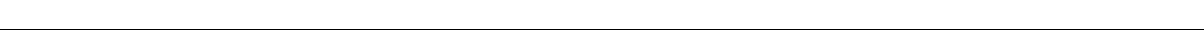
Fig. 1 Optimal delivery of mod-mRNAs and m-miRNAs enhances the reprogramming of human primary fi broblasts. a Transfection ef fi ciency (top) and mean fl uorescence intensity (bottom) of human primary neonatal fi broblasts (FN2) transfected with 500 ng of mod-mRNA encoding mWasabi, using indicated transfection buffers, as determined by fl ow cytometry 24 h post transfection. Error bars, mean ± s.d. for all panels ( n = 3). The results